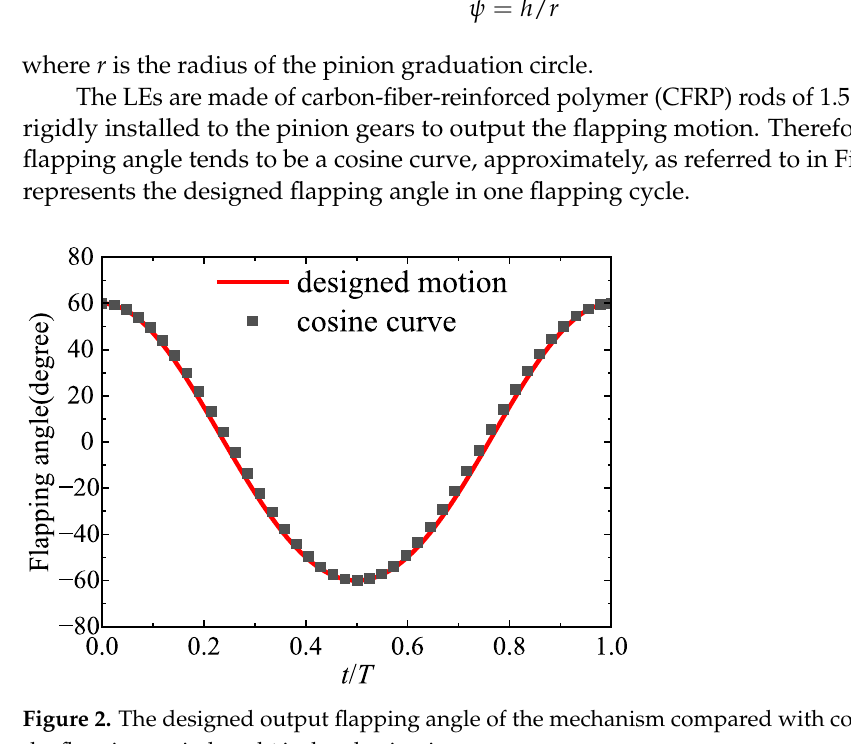
Figure 2. The designed output flapping angle of the mechanism compared with cosine curve. T is the flapping period, and t is the physics time.